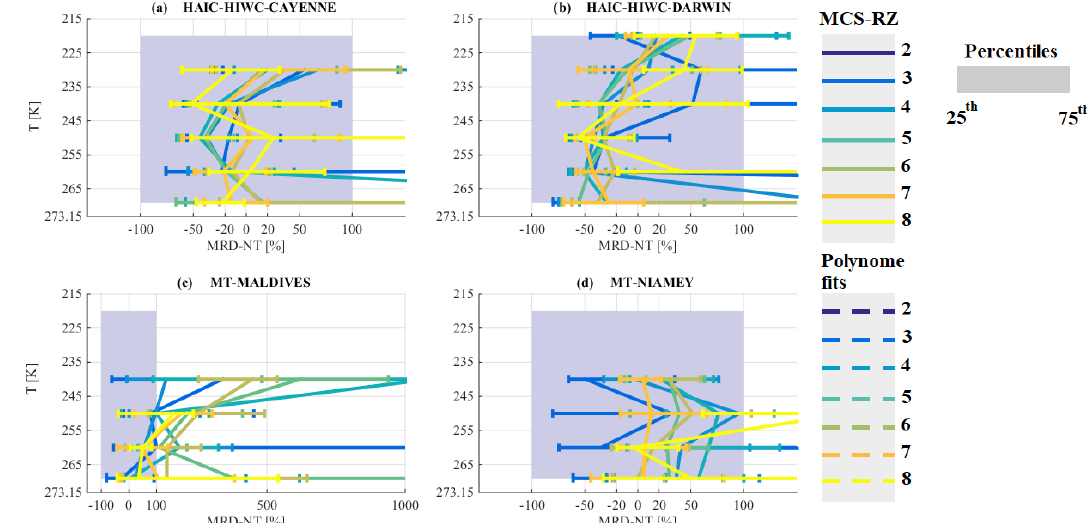
Figure A2. The same as Fig. 6 but for